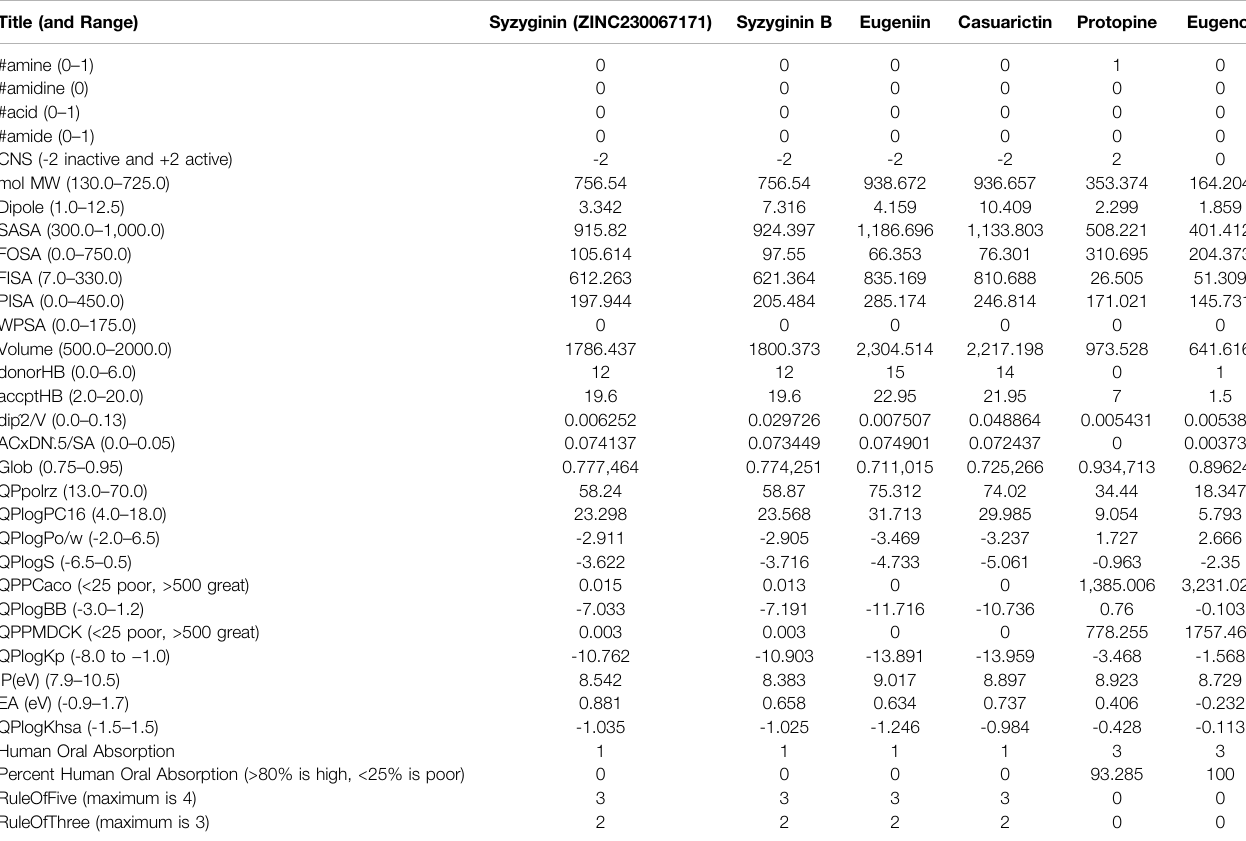
TABLE 2 | ADME/T properties of various compounds that exhibited a high binding ef fi